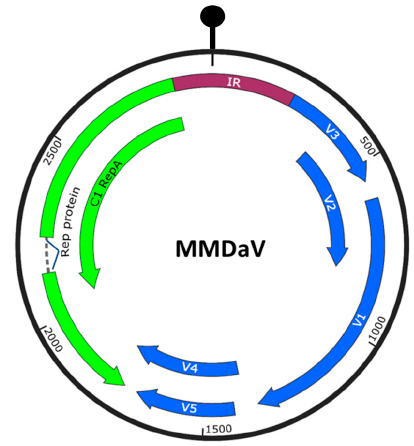
Figure 1. Genome organization of Mulberry mosaic dwarf-associated geminivirus (MMDaV), showing the open reading frames (ORFs) coded. ORFs encoded on the virion-sense (V) strand and complementary-sense (C) strand are denoted as blue and green colors, respectively. The circle represents the circular, single-stranded DNA of MMDaV. The stem-loop structure that contained the conserved nonanucleotide sequence, TAATATTAC, within the intergenic region (IR) is shown on top of the